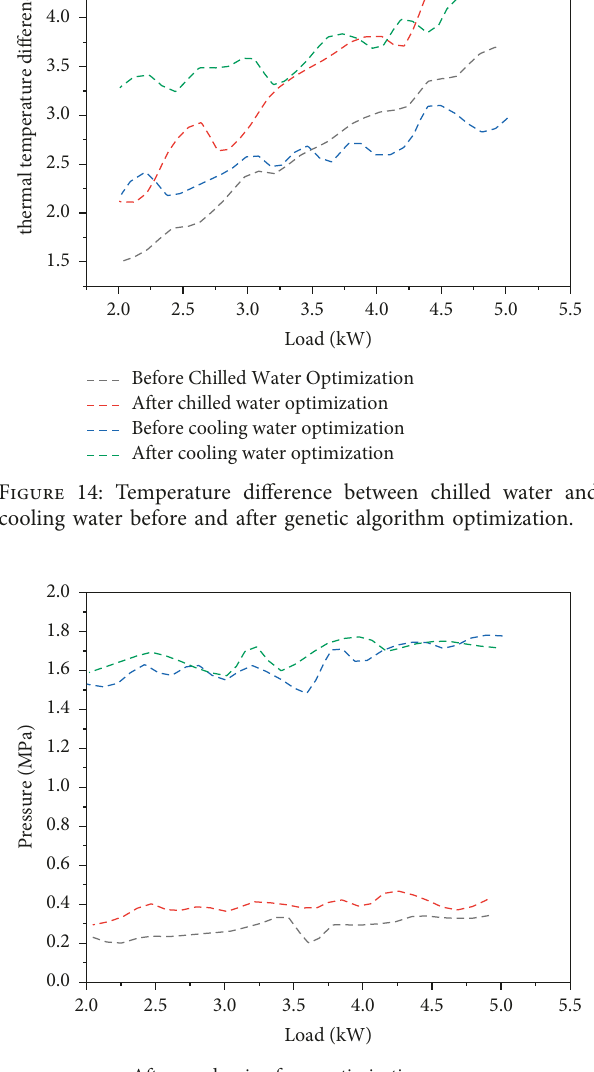
Figure 13: Chilled water and cooling water flow before and after genetic algorithm